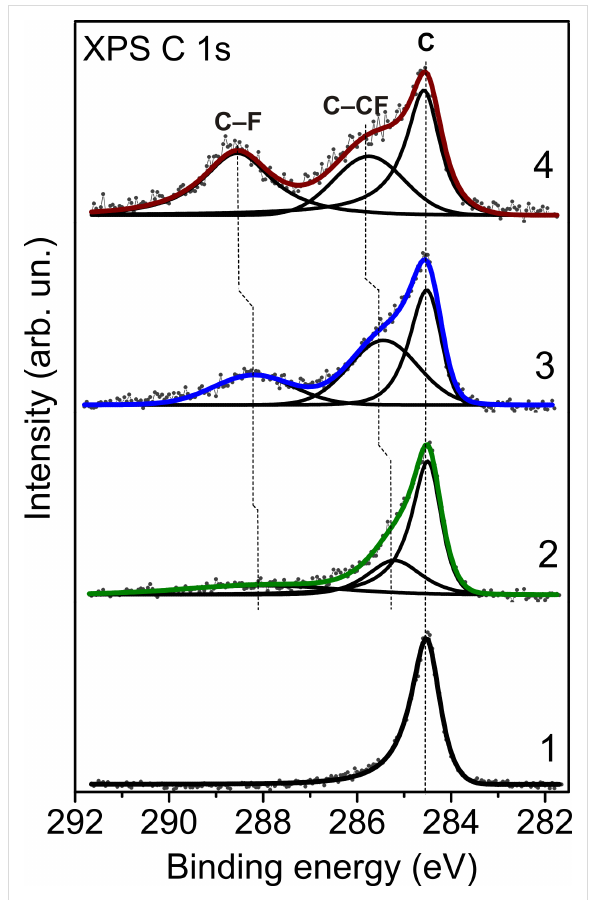
Figure 3: XPS C 1s spectra for pristine DWCNTs (1) and DWCNTs fluorinated with CF 4 plasma (2), BrF 3 (3) and F 2